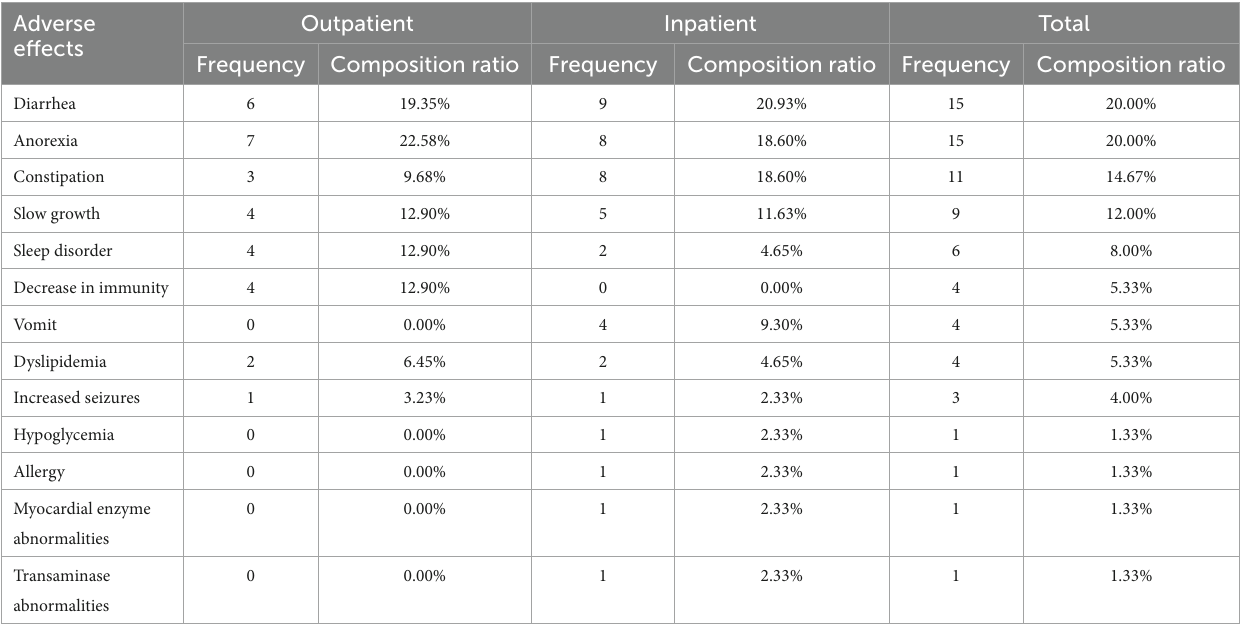
TABLE 6 The distribution of adverse effects. Adverse